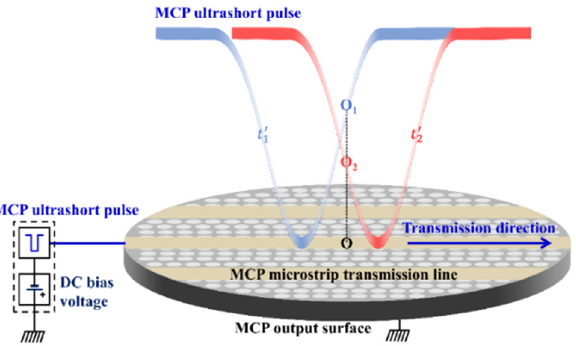
Figure 3. Schematic diagram of the ultrashort pulse transmission along the MCP.